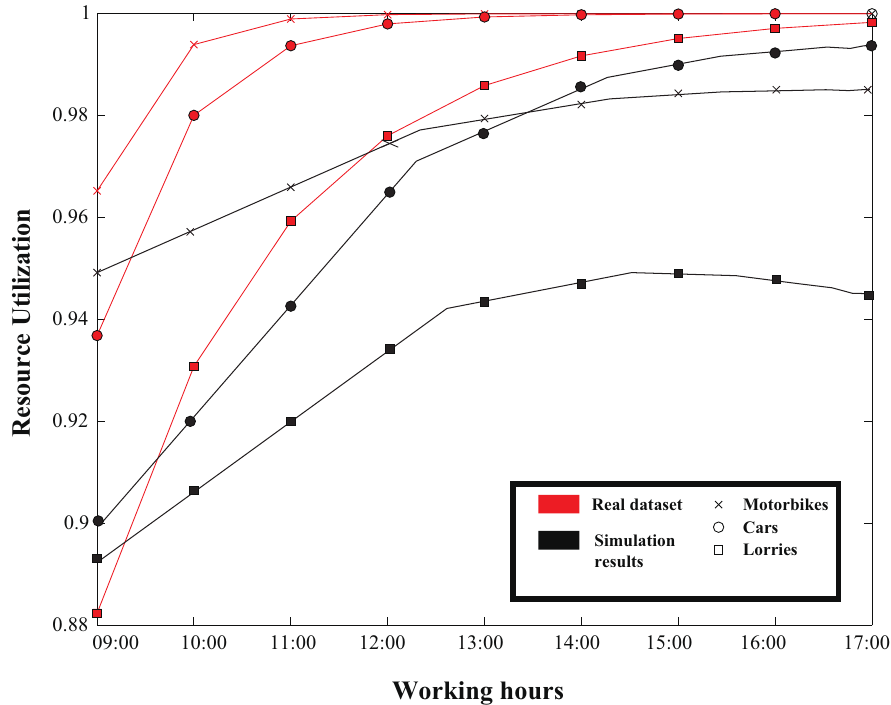
Figure 11. Comparing the actual and simulated non-human resource utilization values. For the human resources, we averaged the actual data for all the drivers and compared against the average values given by our model. The results are shown in Figure 12. Our simulation result indicate that the employees’ utilization is, on the average, about 12% less than the actual one. The peak utilization values were obtained between 12:00 and 14:00 as expected. However, apart from the longer breaks that our model provides (which normally are not taken), our model does not provide equal probability of all drivers of the same class to be used in a shipment, if they are available. However, if one driver has returned from a shipment, even if he has taken a break, his probability of taking over another shipment is reduced compared to a worker that has taken over no shipment or has taken over shorter shipments. This fact somehow reduces the utilization of some drivers, thus reducing the average human resource